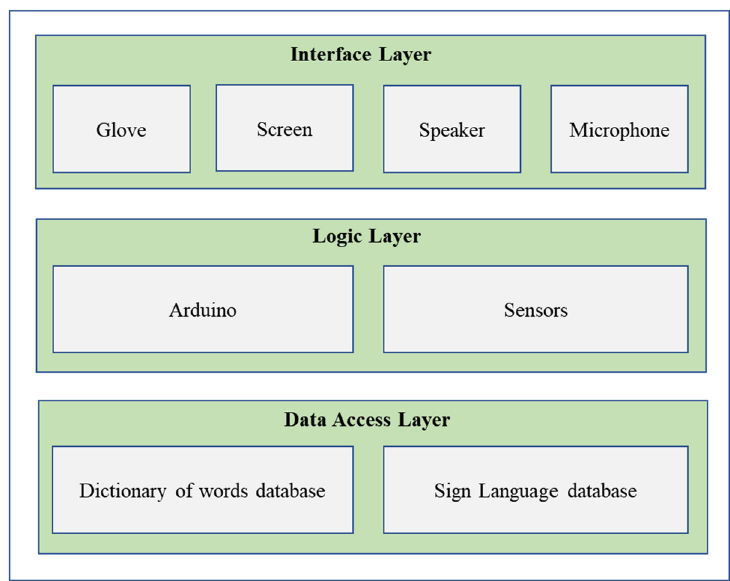
Figure 6: IG ’ s three - layer system